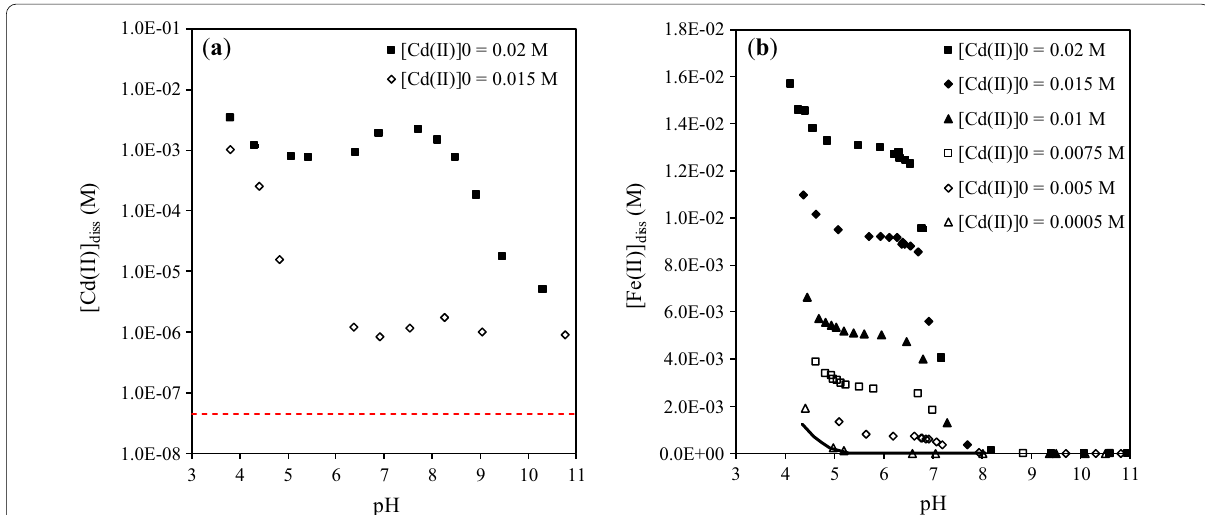
Fig. 1 Dissolved Cd(II) concentration ([Cd(II)] diss ) as a function of initial Cd(II) concentration ([Cd(II)] 0 ) in 2 g/L FeS batches ( a ) and dissolved Fe(II) concentration ([Fe(II)] diss ) as a function of [Cd(II)] 0 in 10 g/L FeS batches ( b ). In part a , the dashed line represents the maximum contamination level (MCL, 5 ppb) according to U.S. EPA. In part b , the solid line represents the solubility of FeS, which was directly measured from FeS batches in the absence of